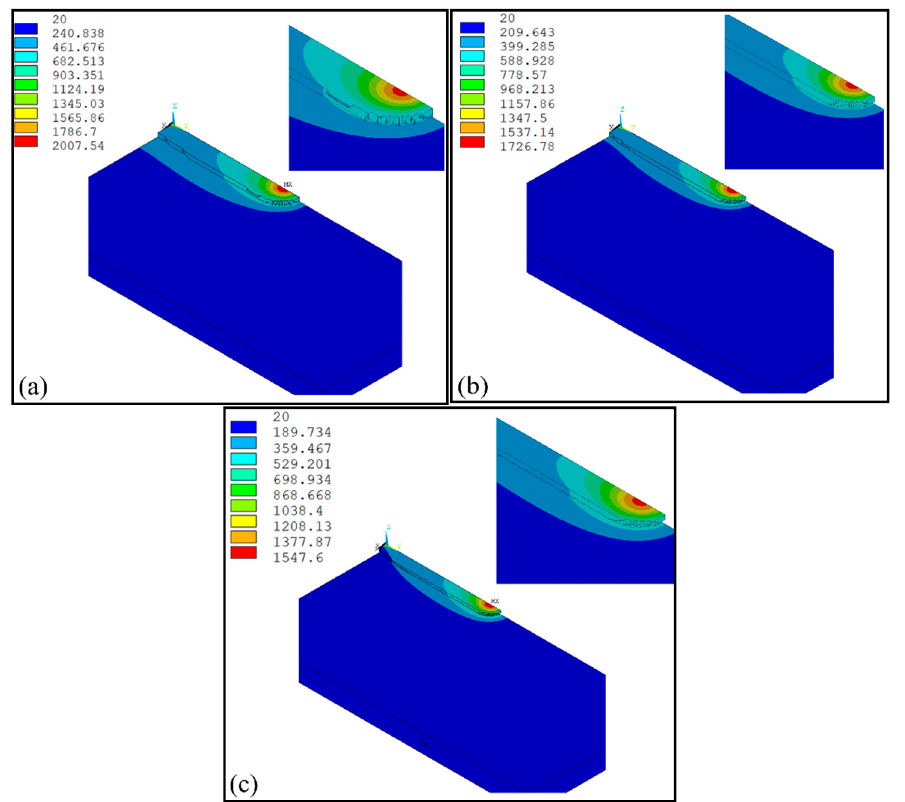
Figure 10. The temperature field distribution of single-track laser cladding at a laser power of 1500 W: ( a ) 0.005 m/s, 3 s; ( b ) 0.01 m/s, 1.5 s; and ( c ) 0.015 m/s, 1 s.